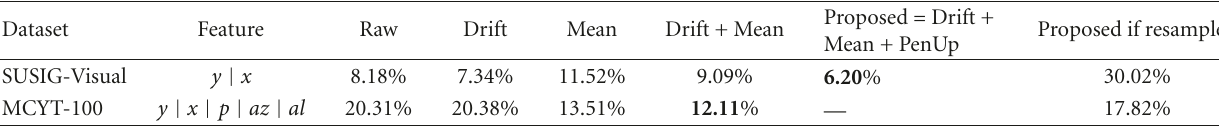
Table 3: E ff ects of various preprocessing steps on the best configuration. The bold face shows the results of the proposed system, while the last column shows the results if resampling was added to the proposed preprocessing steps (drift and mean removal and pen-up duration incorporation when available).